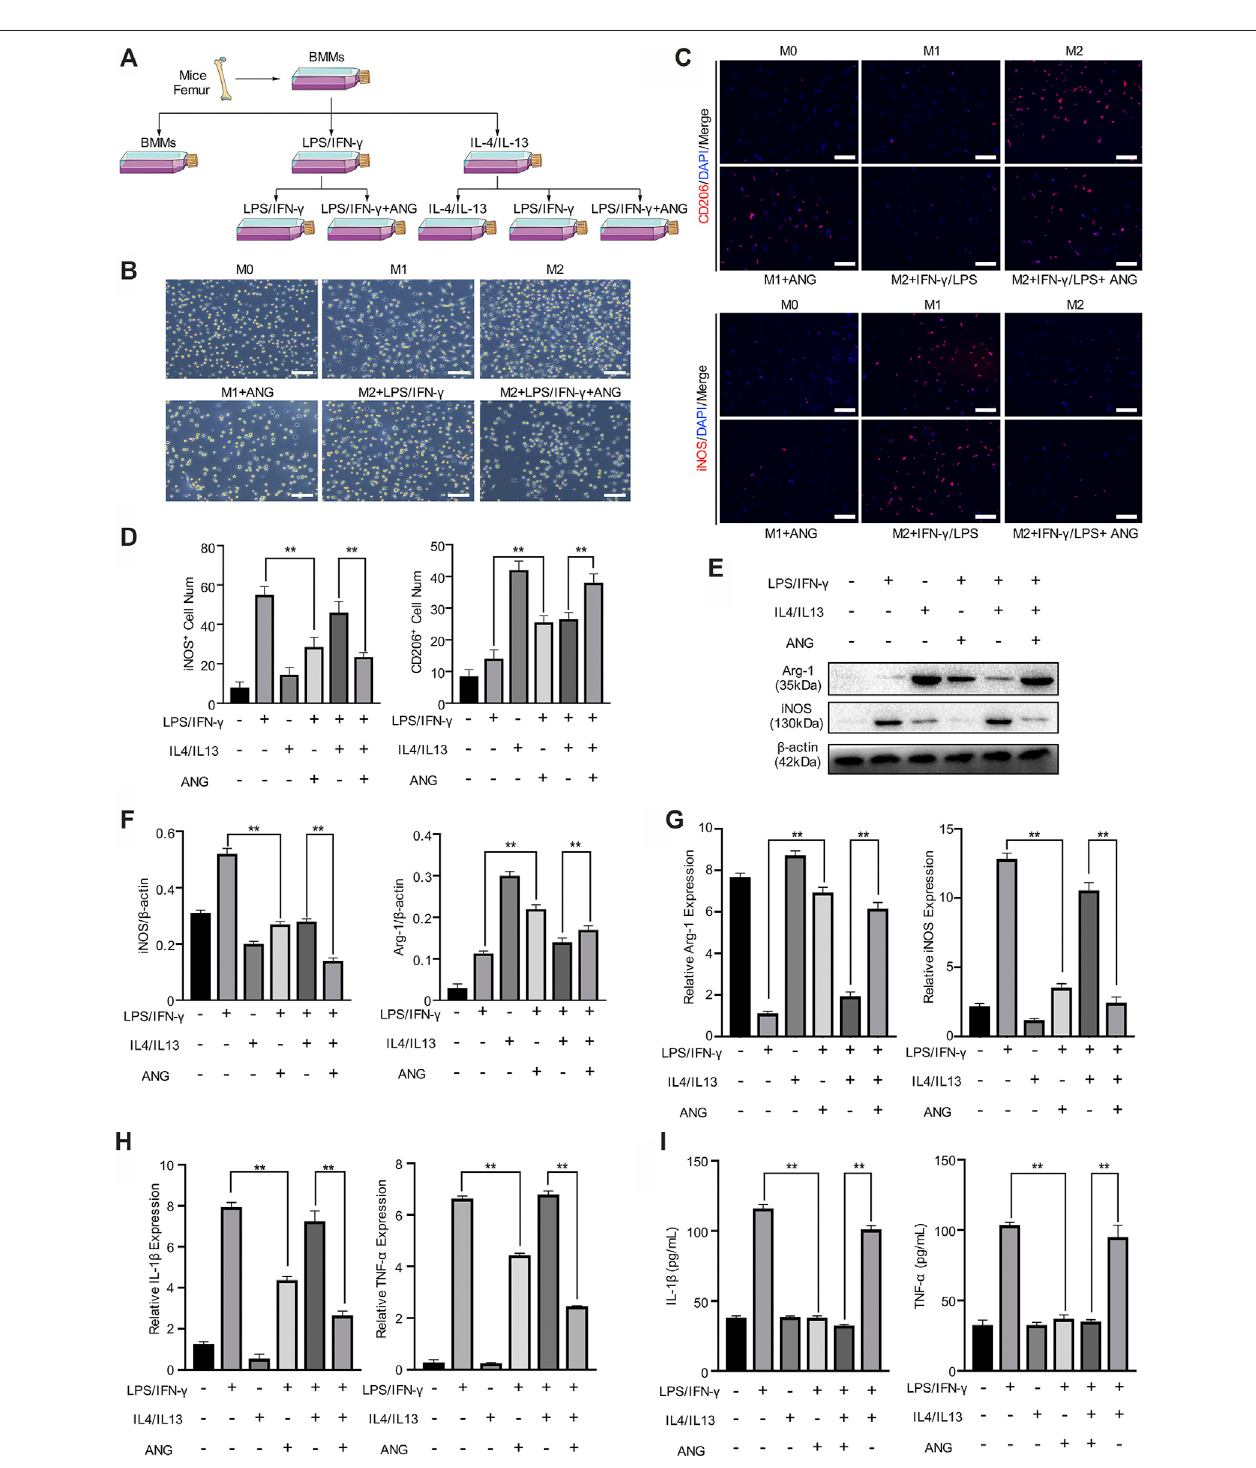
FIGURE 2 | Angelicin protectsM1 polarization and M2 macrophage polarization in vitro . (A) Schematic diagram of bone marrow macrophages (BMMs) isolation and macrophage M1/M2 polarization and repolarization strategy. (B) Representative morphology images in each group of three independent experiments. Bar represents 10 μ m. (C, D) Immunostaining of enzyme-inducible nitric oxide synthase (iNOS) and CD206 (red) in isolated BMMs in different groups with quanti fi cation of iNOS + and CD206 + cell numbers. (E, F) Western blot assay and qRT-PCR assay of Arg-1, iNOS and β -actin in BMMs. (G) qRT-PCR assay of IL-1 β and TNF- α expression in BMMs. (H) ELISA for IL-1 β and TNF- α concentration from cellular supernatant. The data in fi gures represents the mean ± SD. Signi fi cant differences are indicated as ** p < 0.01. Scale bar represents 30 μ m. DAPI, 4 ′ ,6-diamidino-2-phenylindole; IL, interleukin; LPS/IFN- γ , lipopolysaccharide/interferon- γ ; ANG, angelicin.